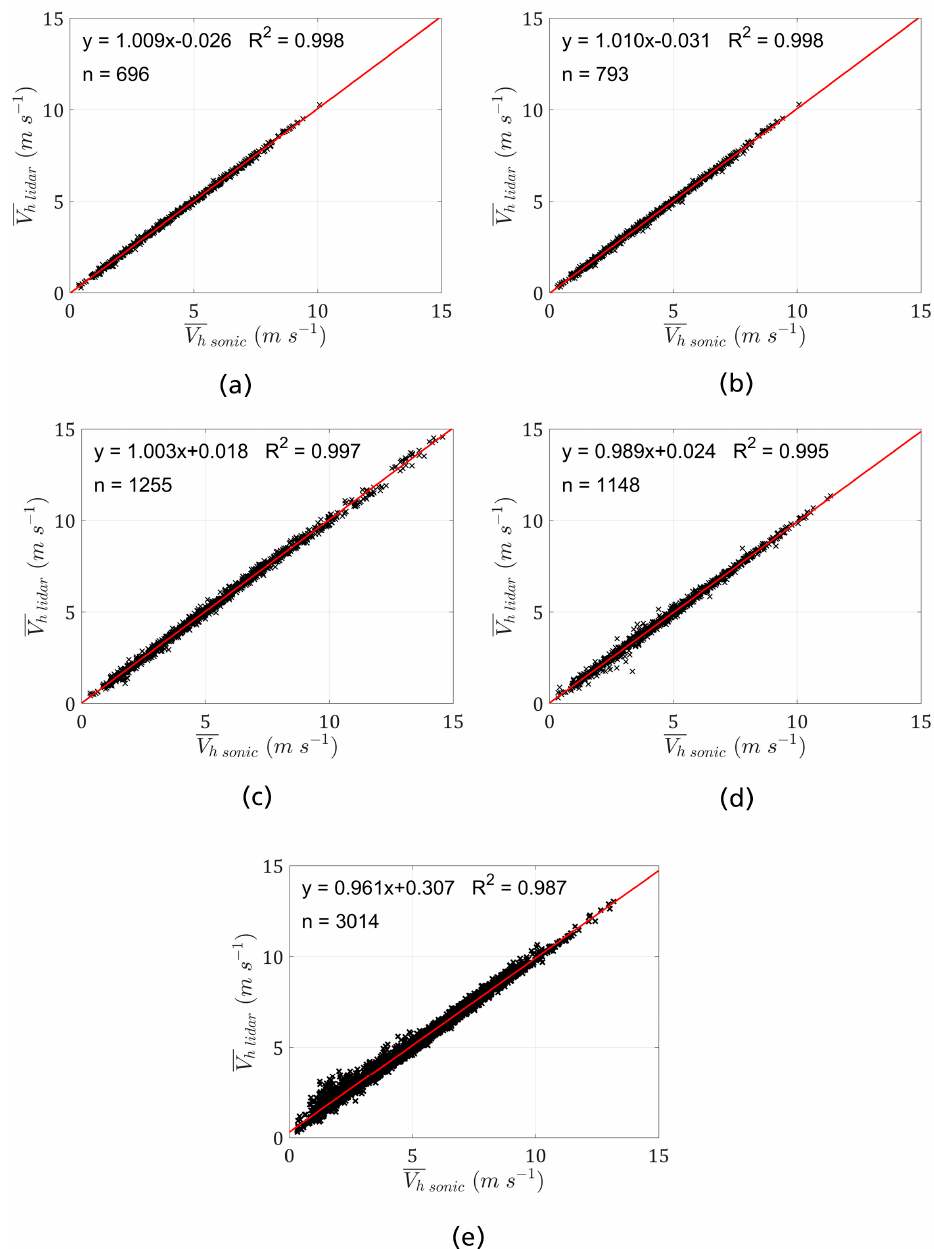
Figure 5. Scatter plots of V h from different lidar configurations against the reference sonic at 188 m; ( a ) SE/SW/EE; ( b ) SE/SW; ( c ) SE/EE; ( d ) SW/EE; ( e ) Windcube v2 next to the mast; ( a – d ) are measurements from WindScanners in ML mode; the Windcube in ( e ) is operated in DBS mode. For ML combinations with only two beams, w = 0 m · s − 1 is assumed in the wind-vector reconstruction; n indicates the number of value pairs displayed in the individual scatter